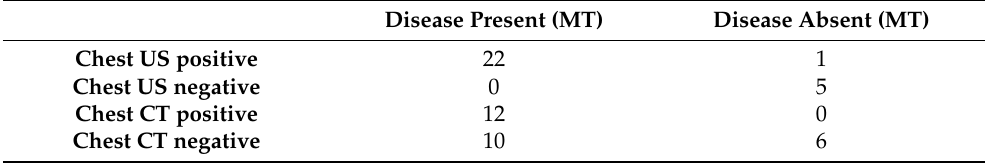
Table 4. Chest US and CT findings compared with MT gold standard.